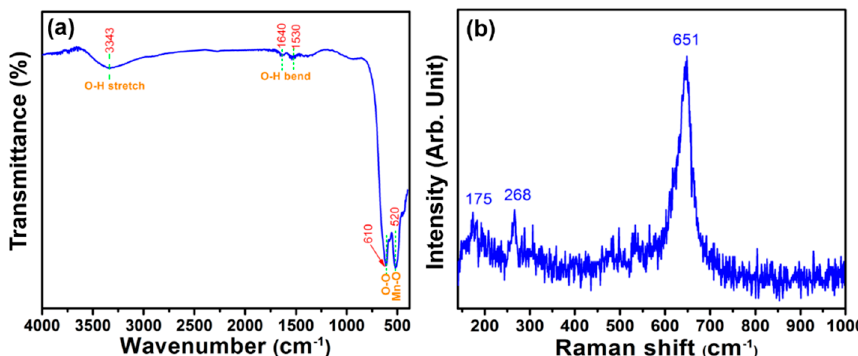
Figure 3. The ( a ) Fourier-transform infrared spectroscopy (FTIR) and ( b ) Raman spectrum of the synthesized mesoporous Mn 2 O 3 materials.